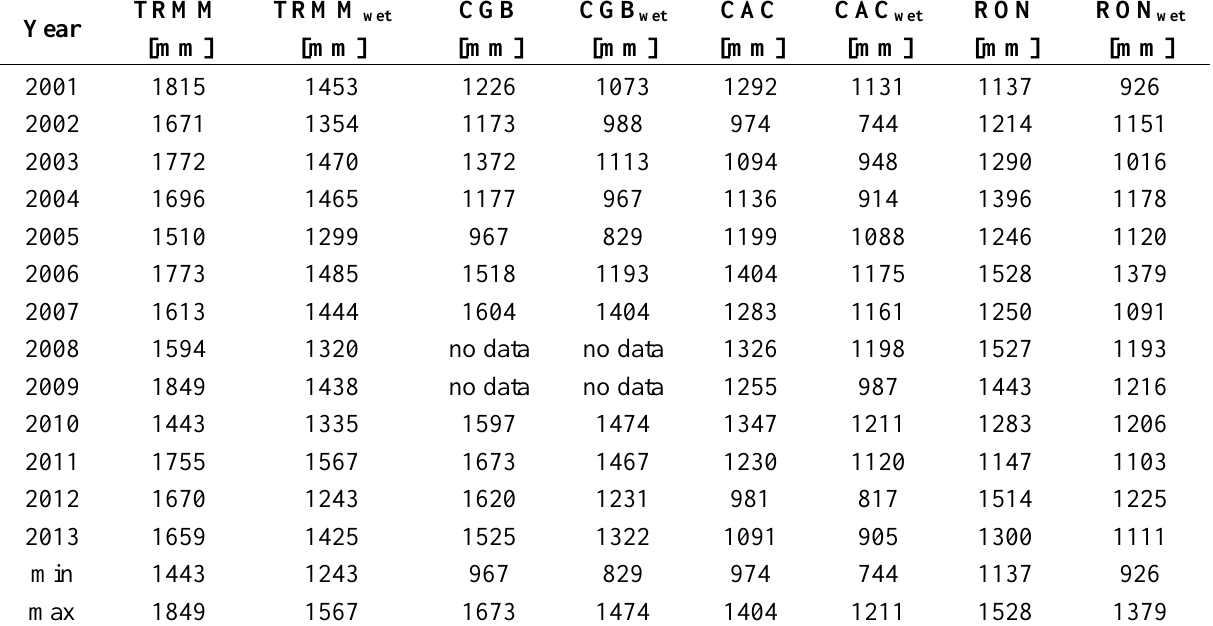
Table A2. Yearly mean discharge of Hidroweb stations from ANA ( Agência Nacional de Águas : National Water Agency in Brazil) (Figure 1a, stations labelled in red,